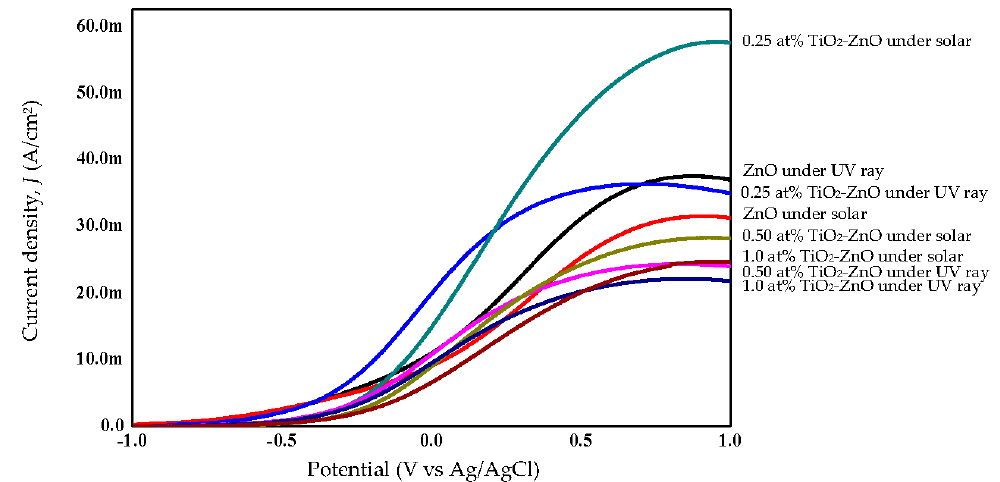
Figure 12. Photocurrent response for combination of all samples with respect to UV ray (300 nm) and solar illumination. Table 5. The photocurrent density (mA/cm 2 ) (with V vs. Ag/AgCl) of ZnO, 0.25 at % TiO 2 -ZnO, 0.50 at % TiO 2 -ZnO, and 1.0 at % TiO 2 -ZnO under UV illumination and solar illumination.